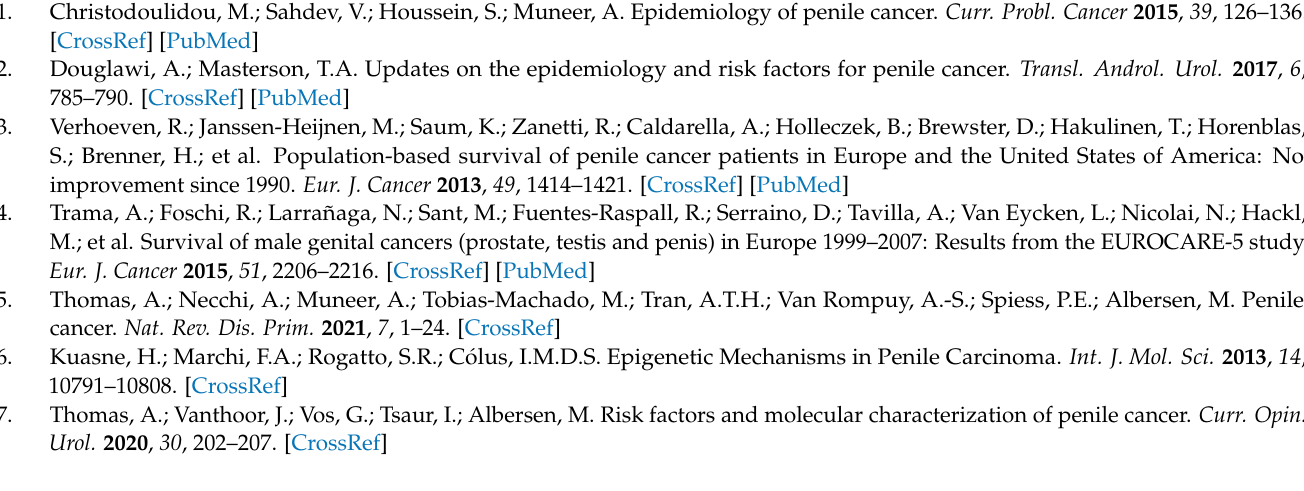
PeCa cells, Figure S1: Characteristics of the penile cancer-derived cells; Figure S2: Heatmap of the reverse phase protein array (RPPA) showing the protein expression levels (in alphabetical order); Figure S3: Ideogram of primary tumors (thin lines in pink) and derived cell lines (thin lines in blue) showing the copy number alterations (CytoScan HD,